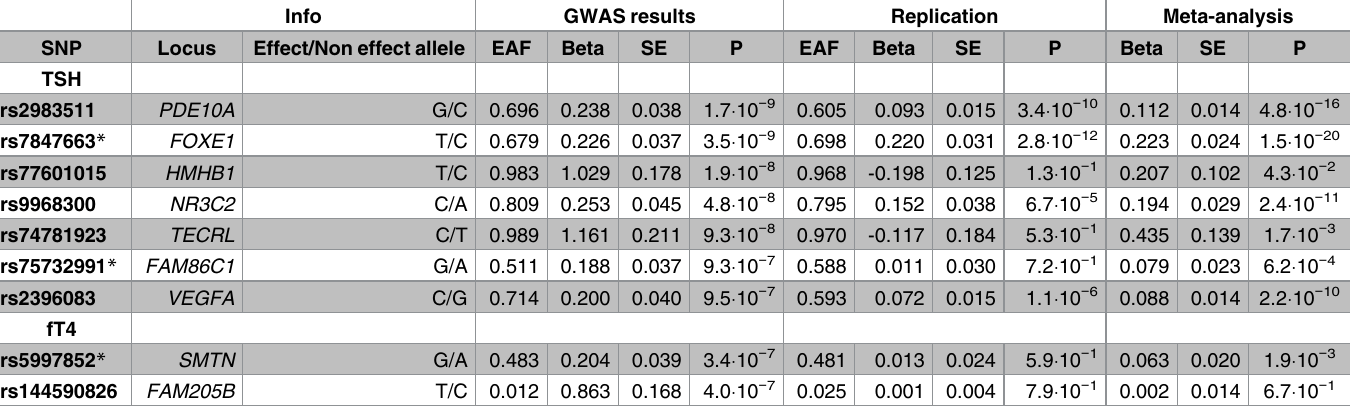
Table 1. Lead SNPs from the discovery-, replication- and meta-analyses.